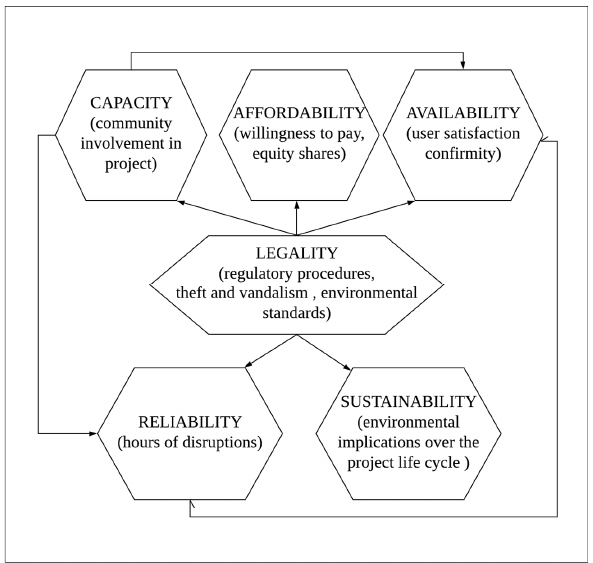
Figure 3. Attribute relationship diagram of the CAARLS attributes.